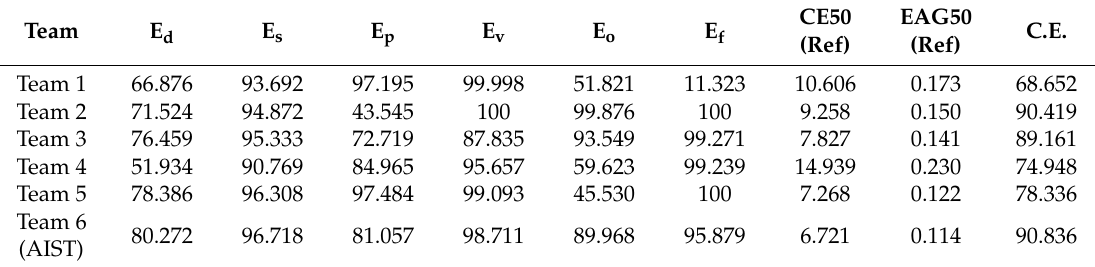
Table 2. Results of evaluations in the PDR Challenge 2017. C.E: comprehensive evaluation score, EAG: error accumulation